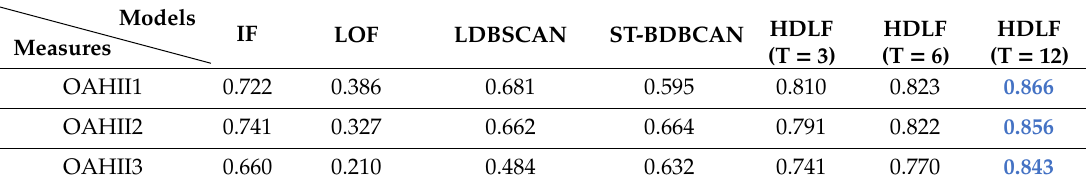
Table 3. Quantitative evaluation of